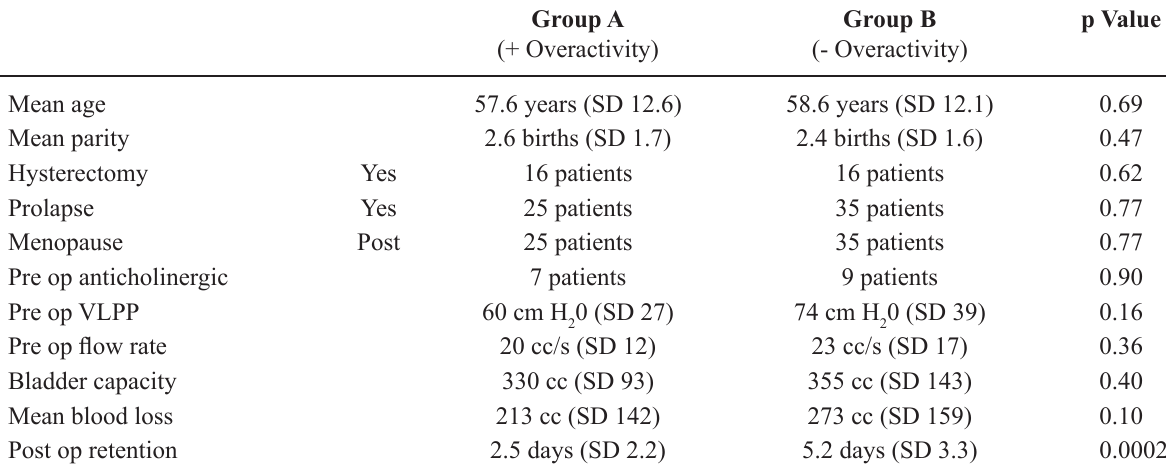
Table 1 – Patient